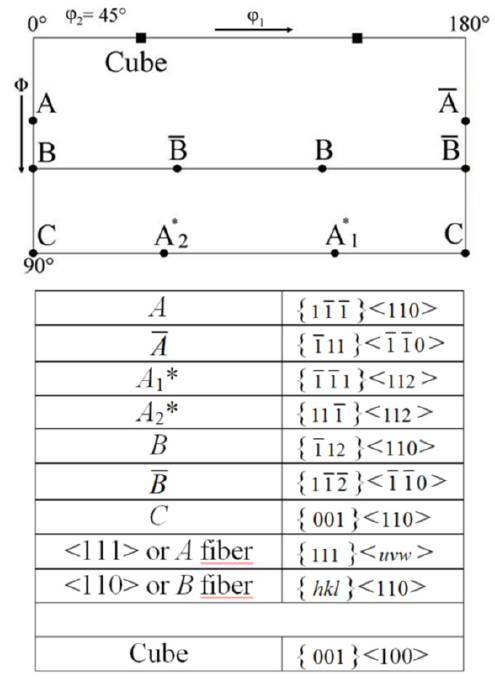
Figure 7. Key figure of shear texture components of HPT deformed fcc phase and their crystallo- graphic description with regard to shear plane {hkl} and shear direction <uvw>. The cube component is also given for the texture analysis of Figure 12 below.